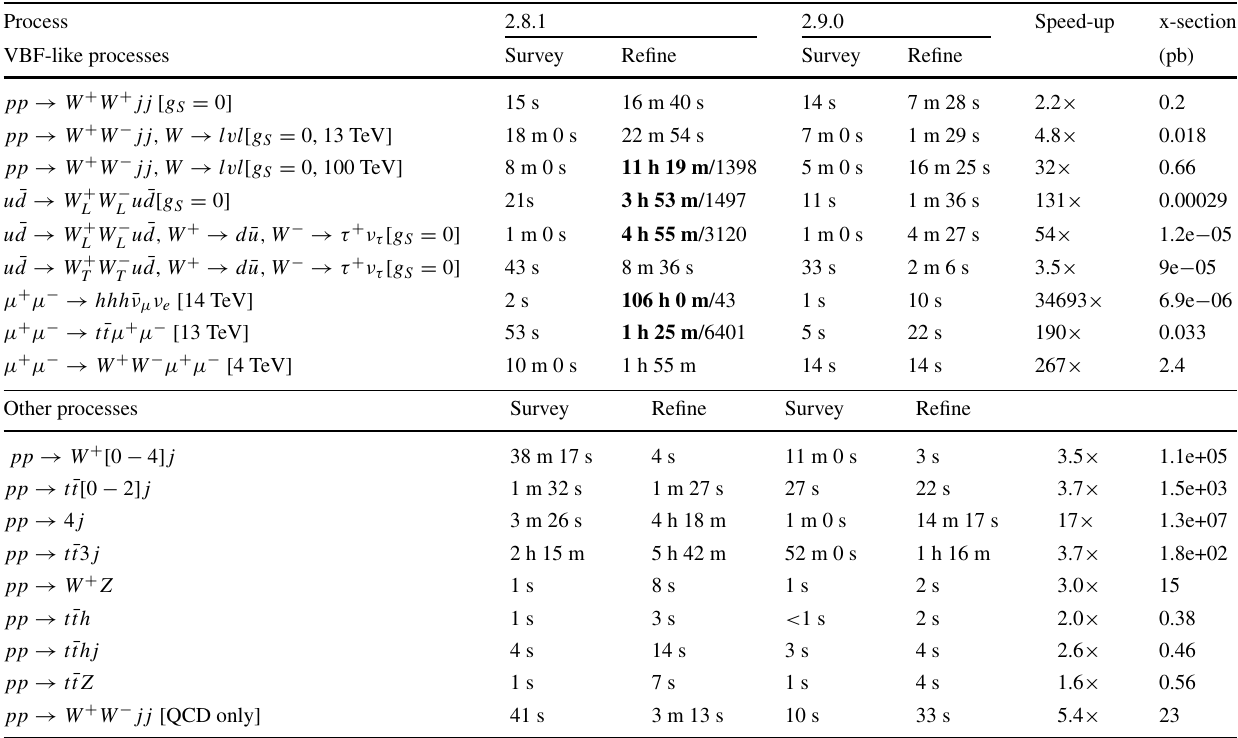
Table 7 Integration timing (time to solution) on a mac-book pro (quad- core 2016) to generate 10k events. If in 2.8.1, it was not possible to generate ten thousand events, the time is re-scaled accordingly (and the